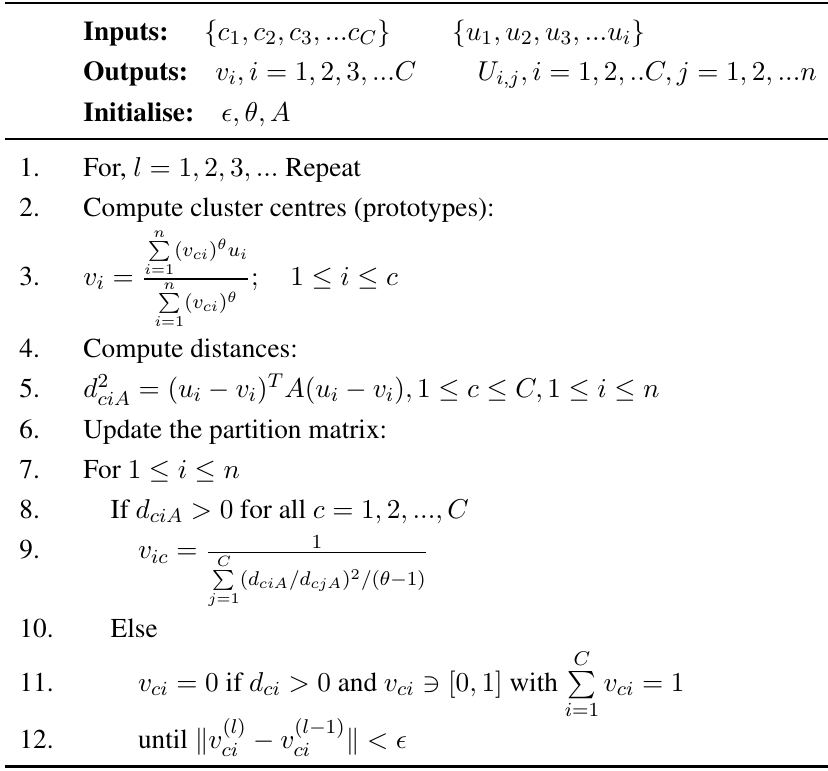
Algorithm 2. Fuzzy c-means clustering